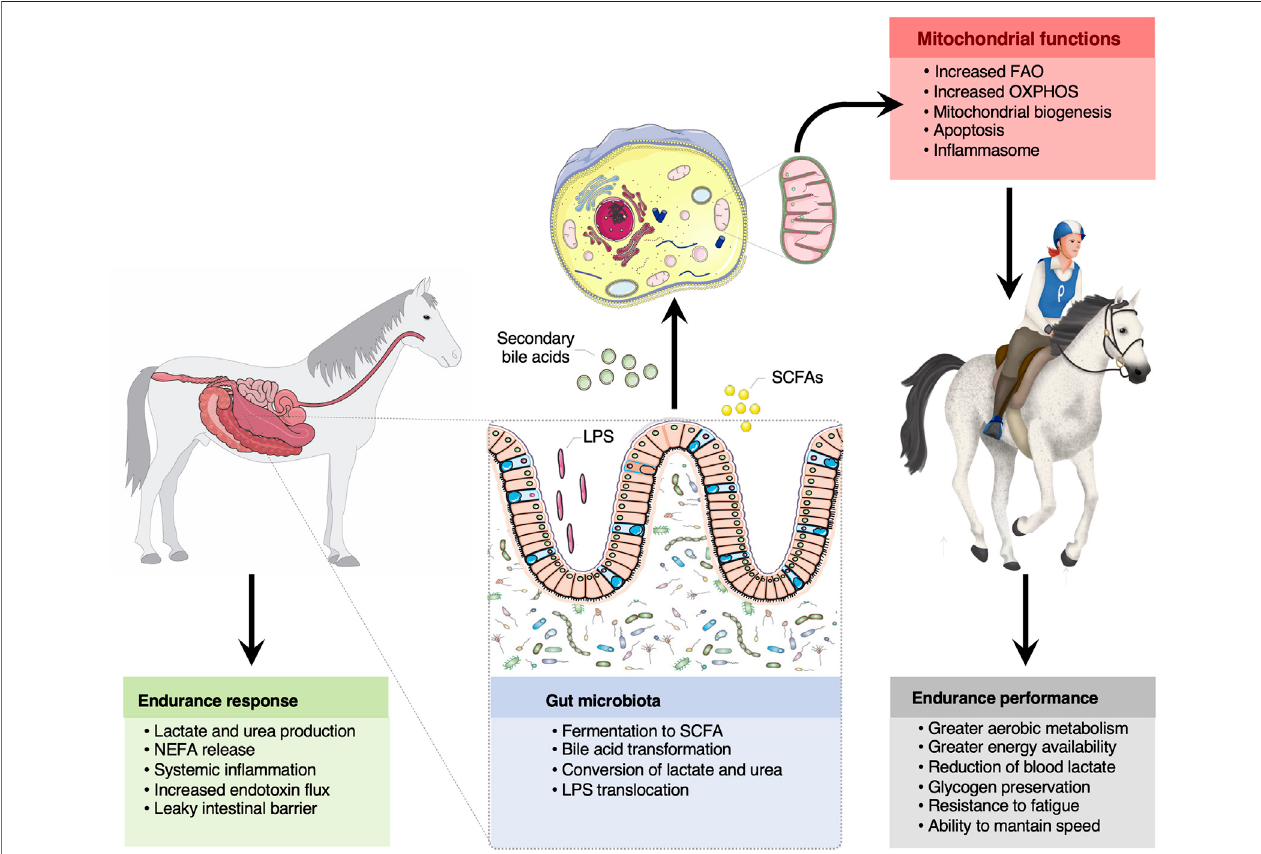
FIGURE5 | The bidirectional crosstalk betweenthe gut microbiota and mitochondria in endurance horses. The intertwined communication betweenmitochondria and gut microbiota was likely mediated by microbiota derived byproducts (SCFA and secondary bile acids), which regulate mitochondrial redox balance, in fl ammation and energy production during intense exercise. Among the SCFA, butyrate appeared as a key regulator of mitochondrial energy production and oxidative stress. Increased lactate and urea concentrations upon prolonged exercise likely entered the gut lumen and were subsequently transformed into SCFA. It is also suggested that circulating free fatty acids participated in the mitochondrial regulation of the in fl ammatory processes elicited by oxidative stress, microbial dissemination and microbial lipopolysaccharides translocation outside of the gastrointestinal tract, as often occurs in endurance athletes. Whether these mechanisms confer an advantage for endurance performance remains still speculative, but results raise the possibility that gut-microbiota crosstalk is pivotal for greater energy availability, aerobic metabolism, glycogen preservation, resistance to fatigue and to maintain speed during the race. Written permission for publication of the horse drawings was obtained.Thepicturesofthemitochondriaandgutweredownloadedfromhttps://smart.servier.com.Inallcases,nochangesweremade.ServierMedicalArtbyServier is licensed under a Creative Commons Attribution 3.0 Unported License.